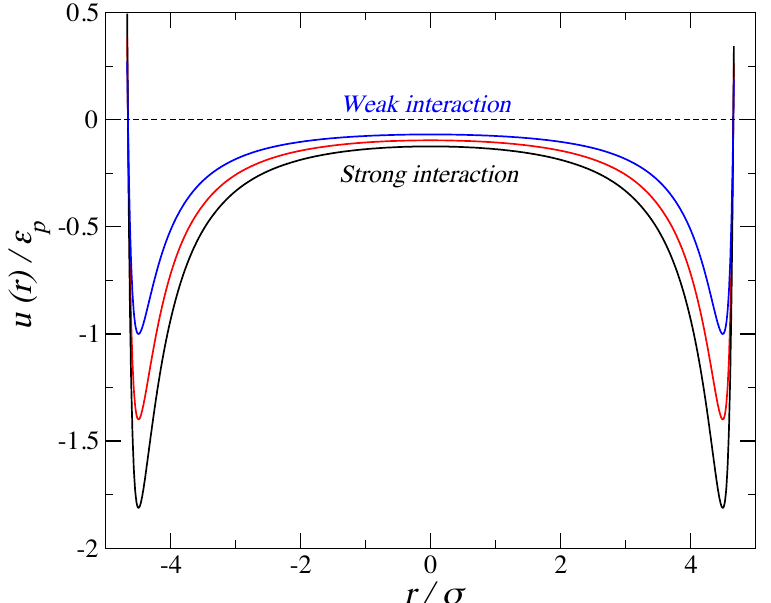
Figure 2. Fluid–solid intermolecular potentials for the cylindrical pore of radius 1.5 nm using three different values of fluid-wall energy, normalized with respect to the well depth of the weakest ( ε p = 13.8 k b ). Distances are normalized with respect to the soft diameter of a single fluid bead ( σ = 0.3